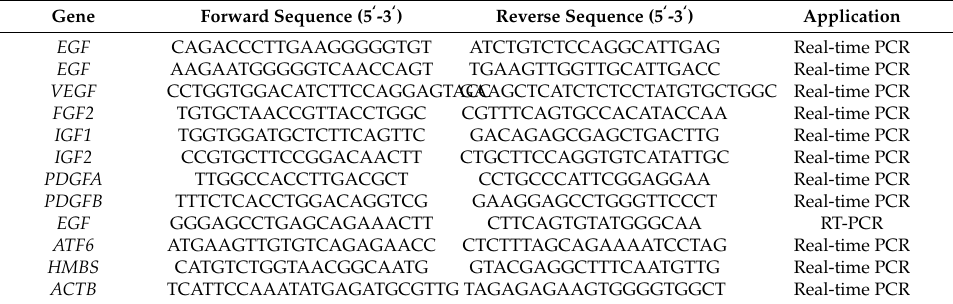
Table 1. Primer sequences used in this